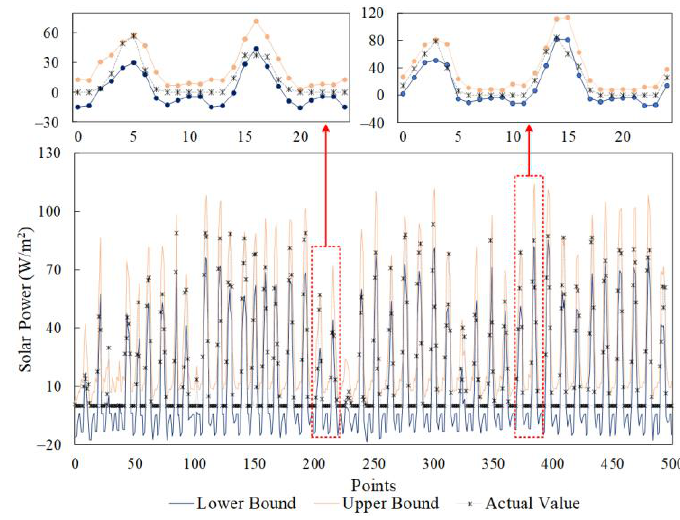
Figure 9. The prediction result obtained by PSO and PI w/o ELM-AE.